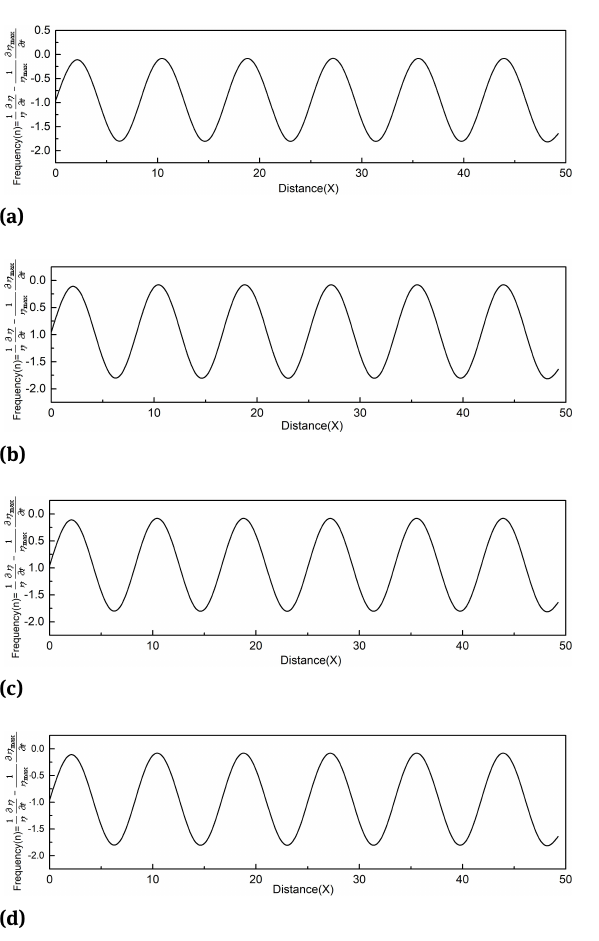
Fig. 3: Different values of M 0 =0.2, 0.25, 0.3, and 0.35 with fixed values of B = 0.02, β = 2, (cid:96) = 0.75 and β